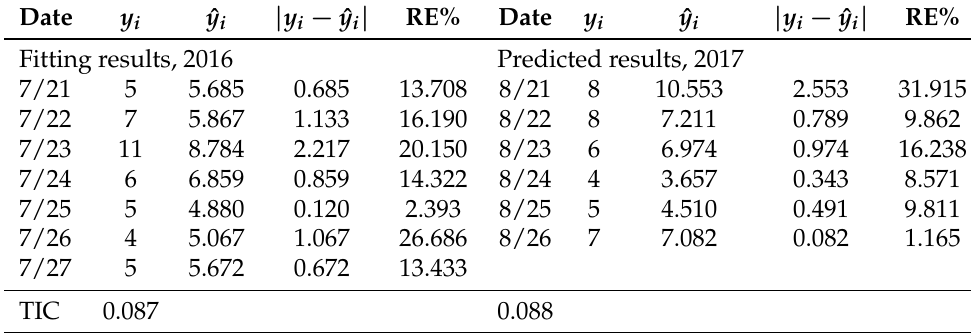
Table 8. Fitting and Predicted results ˆ y i for the Model VI based on biweight